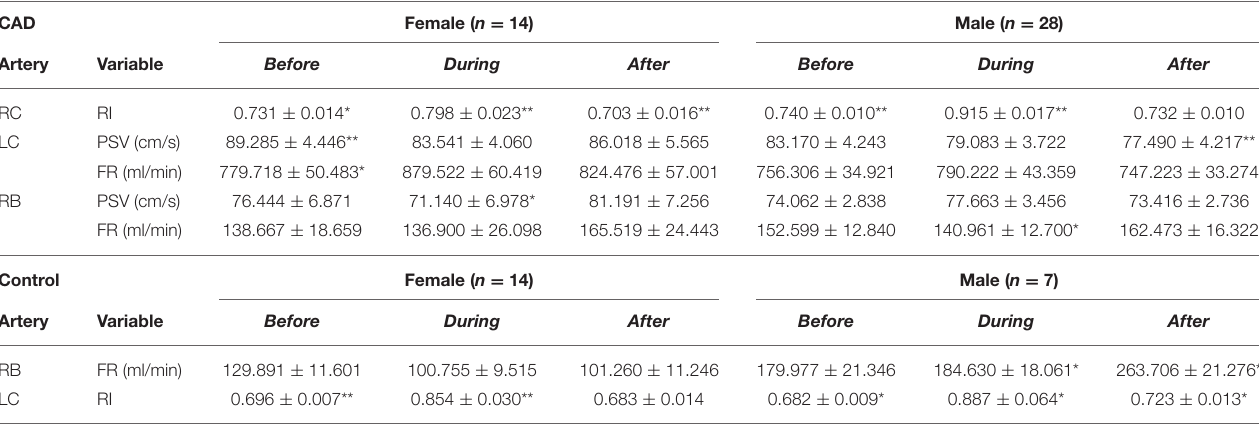
TABLE 2 | Significant differences of the hemodynamic variables for the patients with CAD and controls by subgroup analysis.